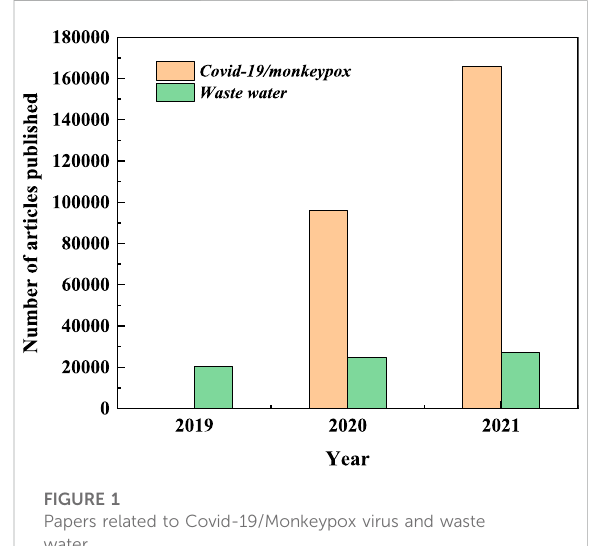
Papers related to Covid-19/Monkeypox virus and waste